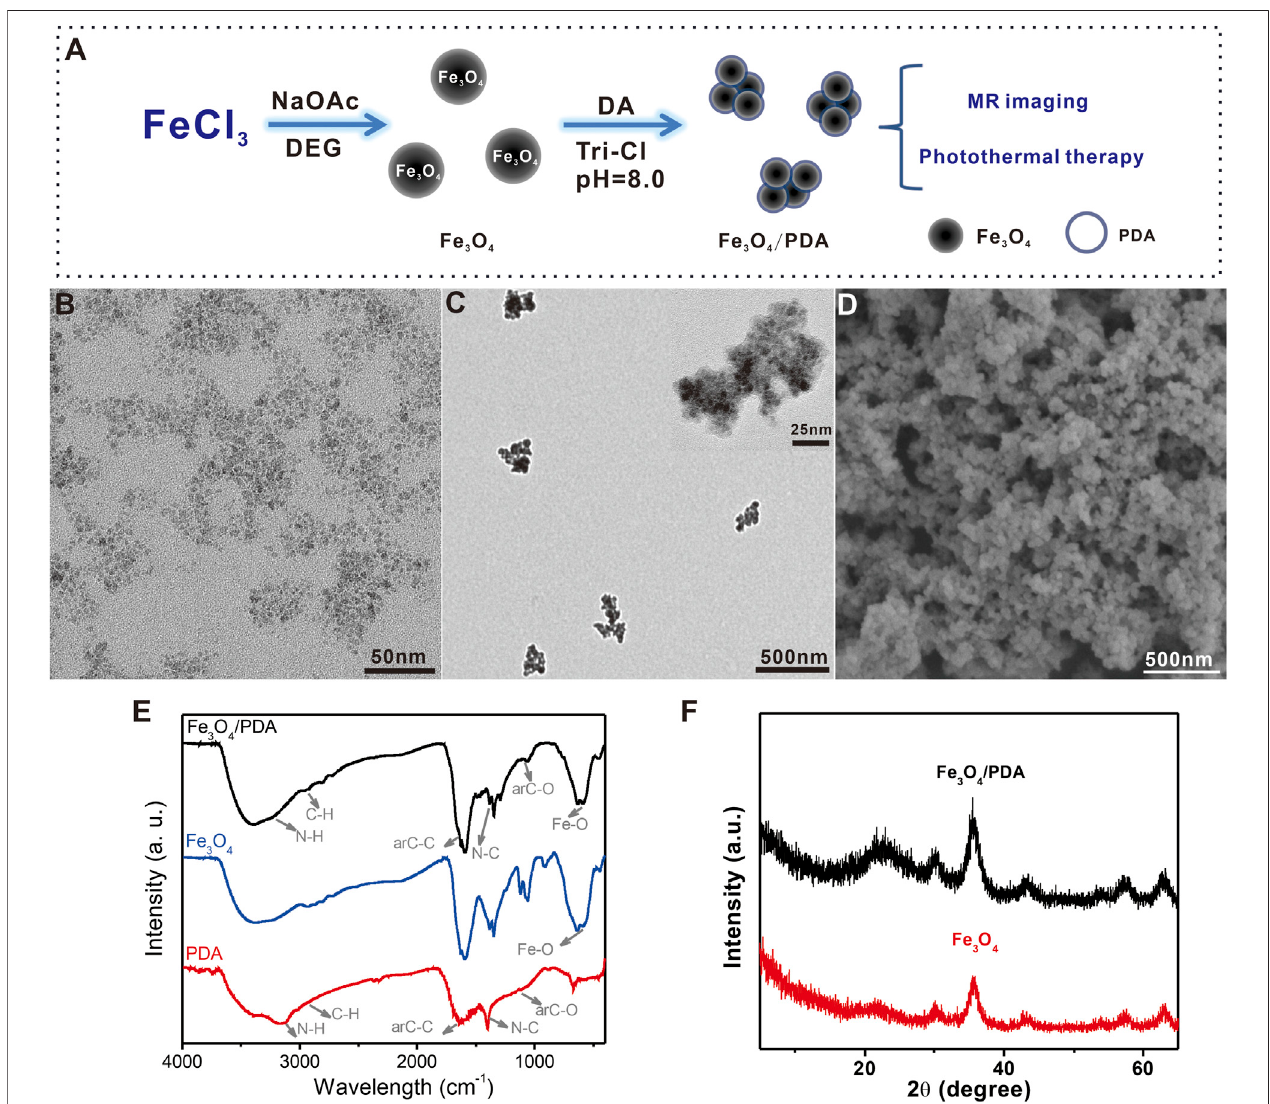
FIGURE 1 | (A) Schematic overview of the Fe 3 O 4 @PDA nanocomposite preparation process. (B,C) TEM images of Fe 3 O 4 @PDA nanocomposites. Inset: High-